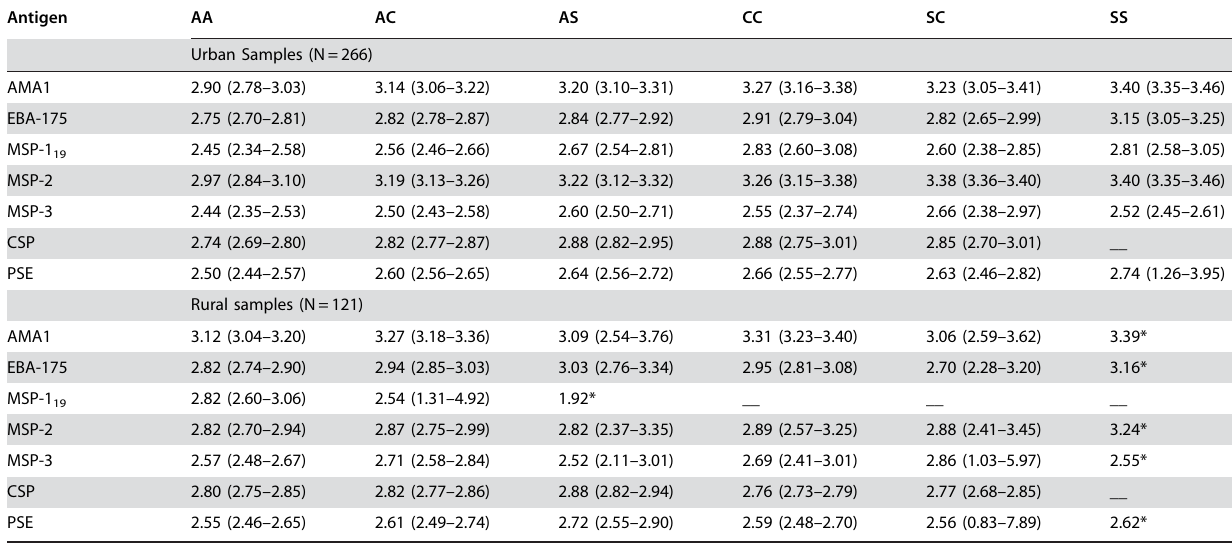
Table 3. Geometric means and 95% Confidence intervals in brackets of log transformed OD values against several blood